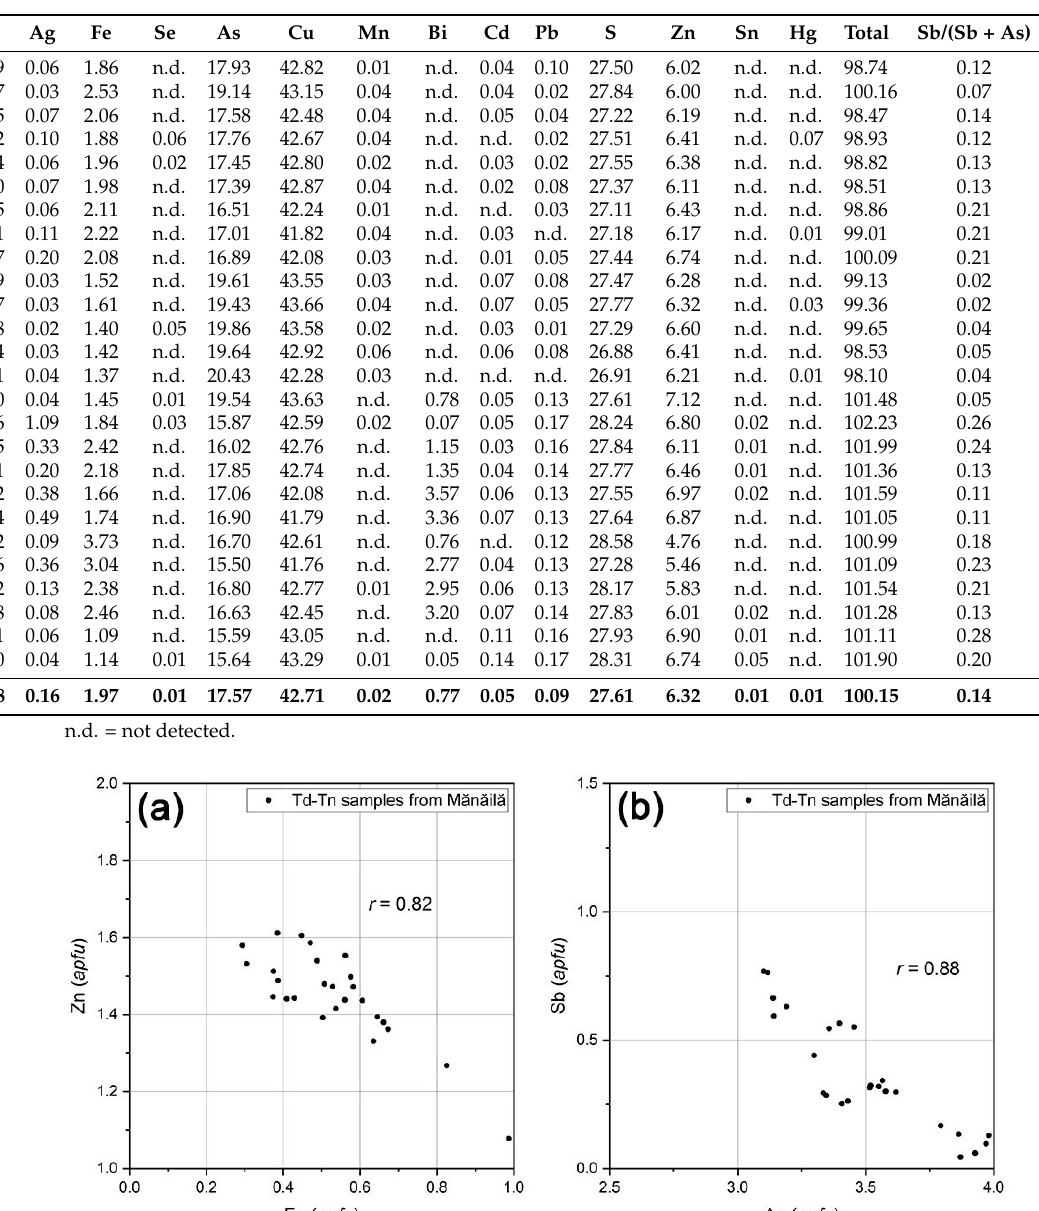
there is a strong negative correlation between As and Sb ( r = 0.88, Figure 11b). Table 6. Electron microprobe analyses of tennantites (wt.%).